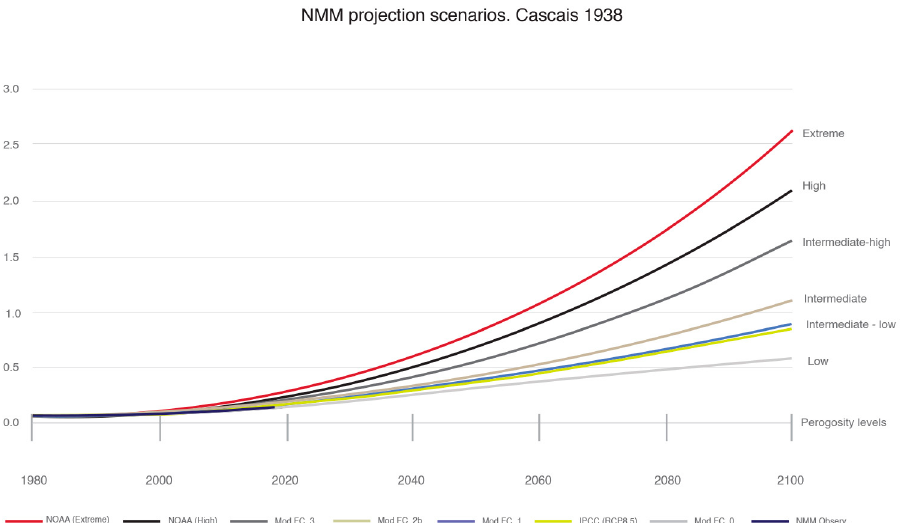
Figure 1. NMM projection scenarios for different hazards, from FCUL, IPCC and NOAA, relative to Cascais Vertical Datum 1938, Authors’ edition based in [9].